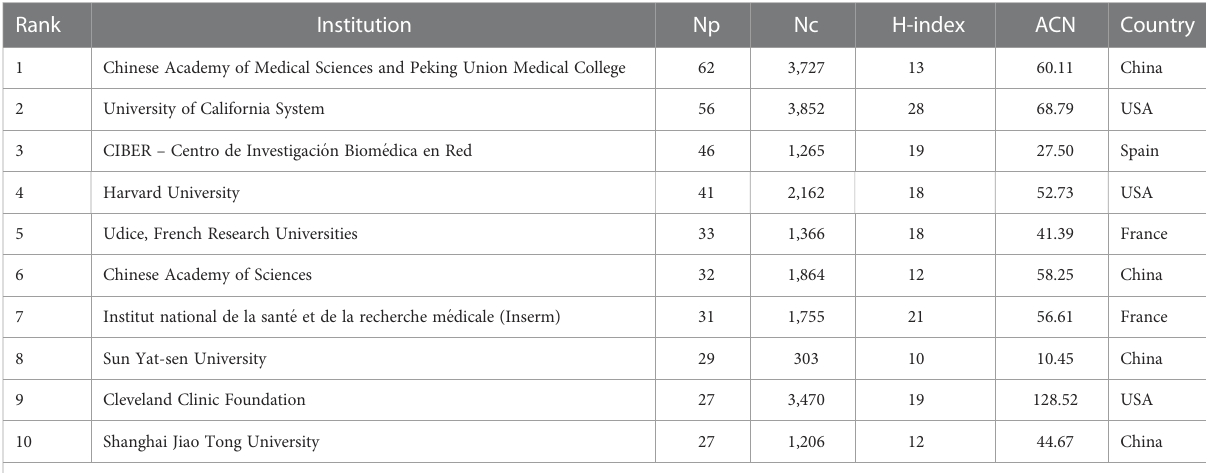
TABLE 3 The top 10 active institutions of GM in